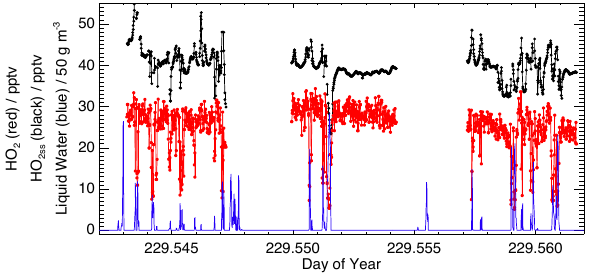
Fig. 14. Correlation between HO 2 (pptv) and HO 2 ss (pptv): slope=0.62 ( ± 0.02); intercept= − 1.75 ( ± 0.44); R 2 =0.33. Green points indicate observations in the boundary layer with isoprene greater than 300pptv. Red points indicate observations within a biomass burning plume with acetonitrile higher than 250pptv. Open circles indicate observations during Flight 228, when J (O 1 D) was significantly greater than expected. Each case is discussed in the text.